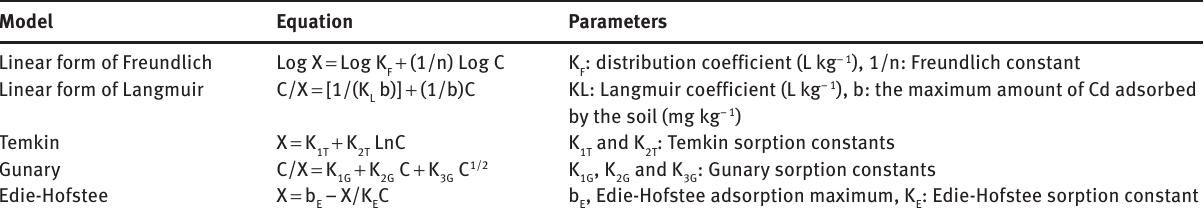
Table 4: Equations used to evaluate the Cd sorption isotherms in calcareous and acid Iranian soils.